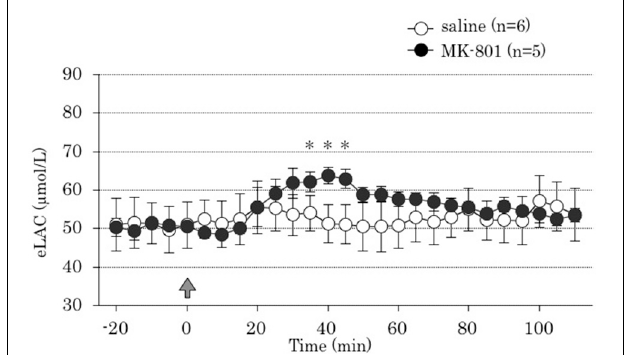
FIGURE 2 | Time course of the effect of 4 days treatment of MK-801 on the extracellular lactate concentrations (eLAC) in the medial prefrontal cortex. Rats were treated with saline (saline group, n = 6; open circle) or MK-801 (MK-801 group, n = 5; closed circle). Lactate levels in the dialysates are expressed as μ mol/l calculated by a standard solution of 100 μ mol/l lactate. Data are mean ± s.e.m. The arrow indicates the timing of the last injection. Asterisk showed p < 0 . 05 vs. saline group in each time point.